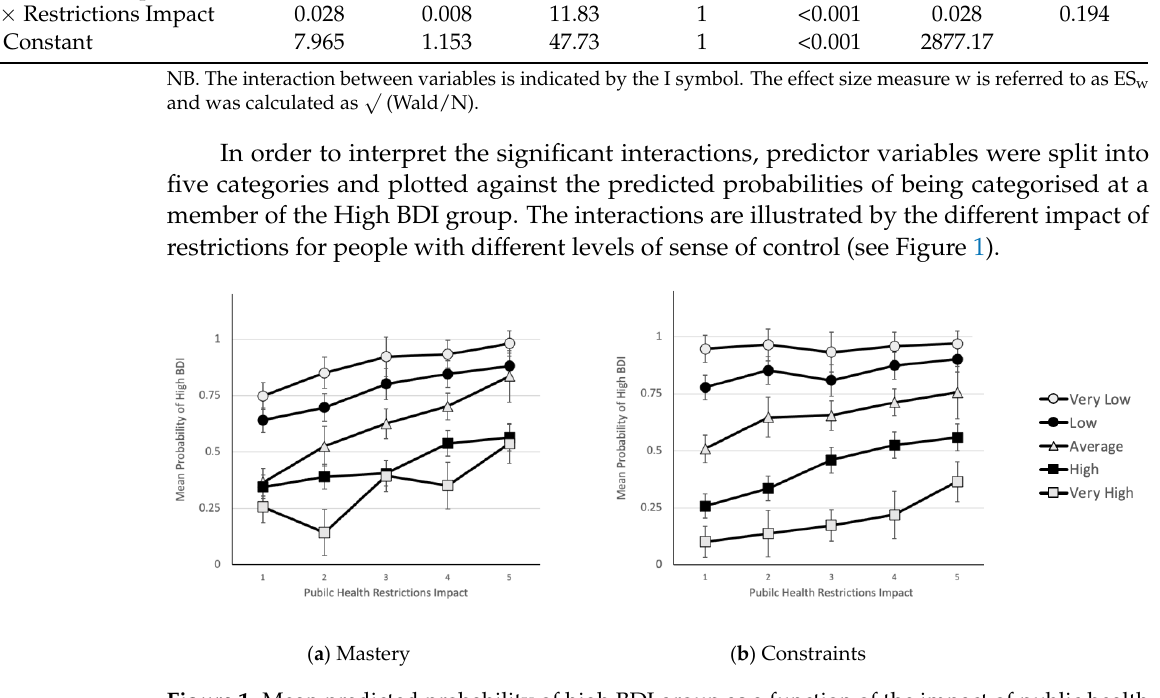
Figure 1. Mean predicted probability of high BDI group as a function of the impact of public health restrictions and sense of control where panel ( a ) shows the interaction with Sense of Control: Mastery; and panel ( b ) shows the interaction with Sense of Control: Constraints. Error bars correspond to the standard errors of the